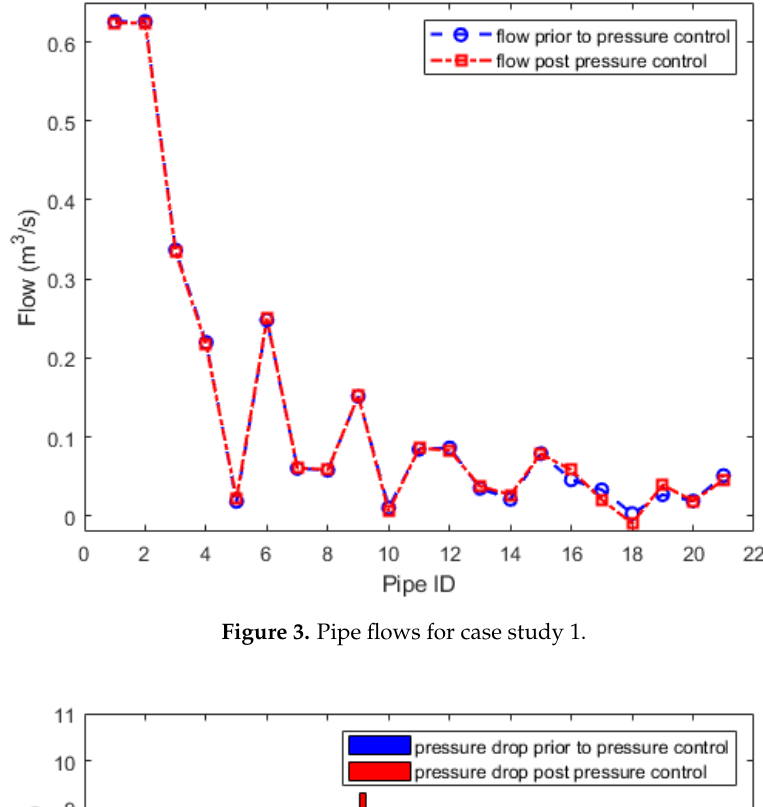
Figure 3. Pipe flows for case study 1.